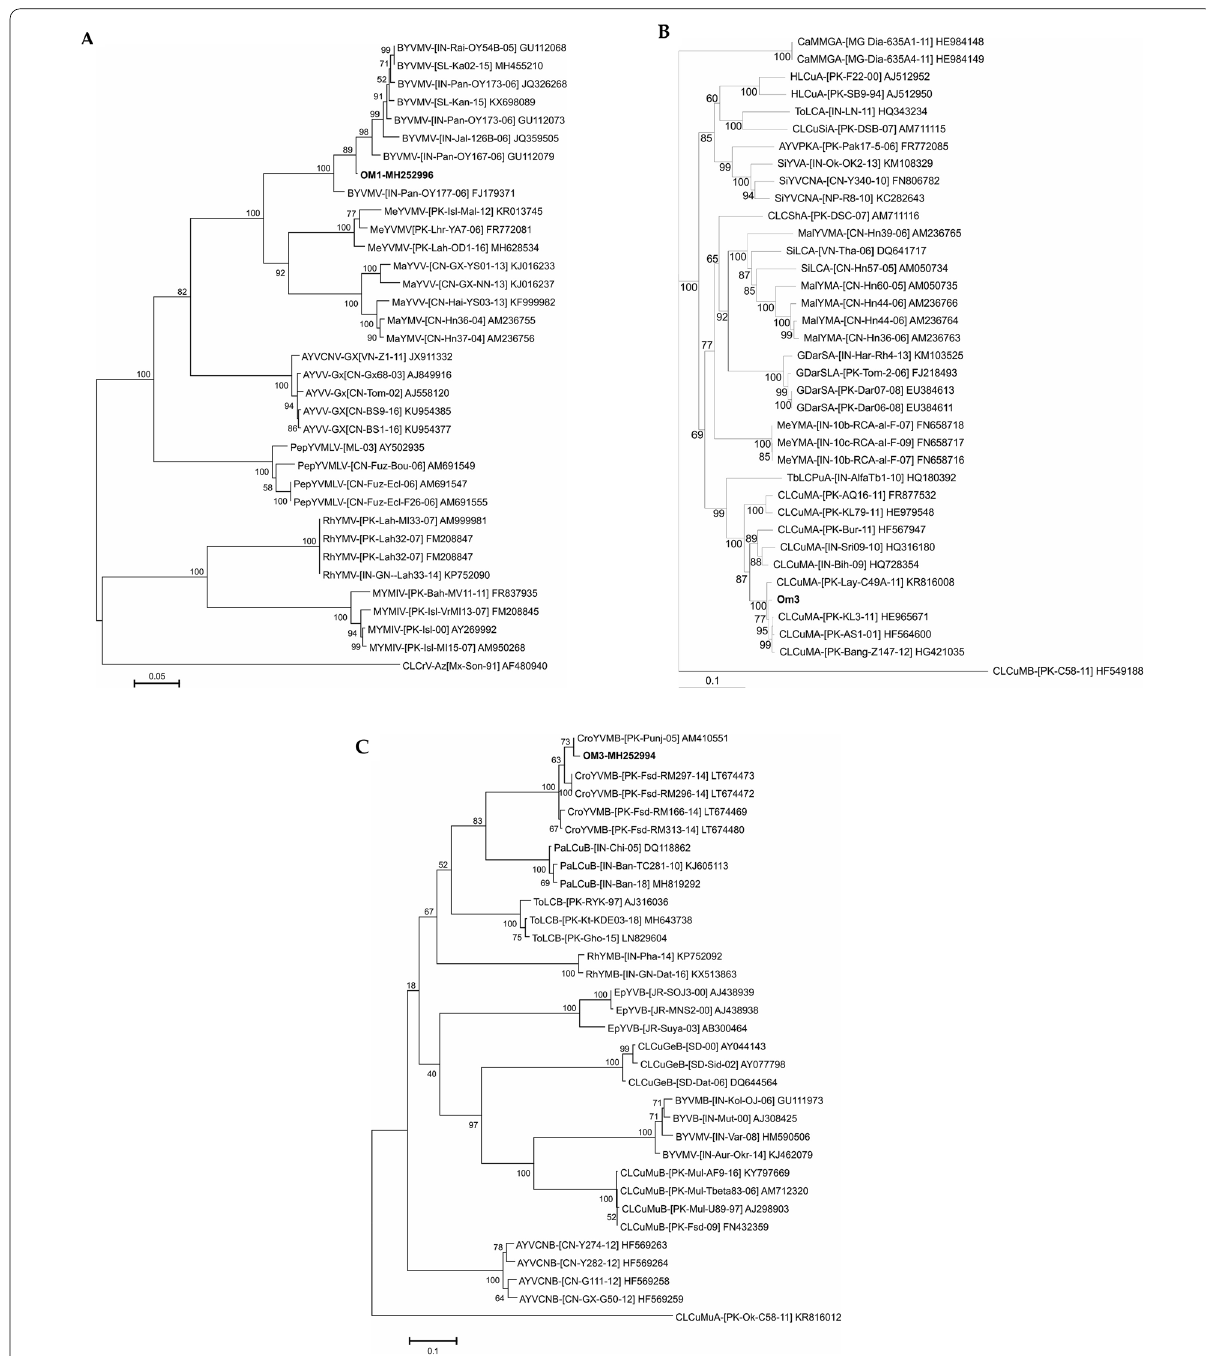
Fig. 2 Phylogenetic trees of BYVMV (OM1), CroYVMB (OM2) and CLCuMuA (OM3). A Maximum likelihood phylogenetic tree of BYVMV was constructed based on MUSCLE alignment of selected begomovirus sequences from GenBank and sequences obtained here. Cotton leaf crumple virus (AF480940) sequence was used as an outgroup to validate the tree. B Phylogenetic tree of CroYVMB was generated by MUSCLE alignment using related betasatellite sequences from GenBank and sequence obtained here. Cotton leaf curl Multan alphasatellite (KR816012) was taken as outgroup. C Maximum likelihood (ML) phylogenetic tree was constructed based on MUSCLE alignments of CLCuMuA (OM3) with the complete nucleotide sequences of selected alphasatellite genomes available in the databases. The tree was arbitrarily rooted on the sequence of cotton leaf curl Multan betasatellite (HF549188), as outgroup. The numbers at nodes represent percentage bootstrap confidence scores (1000